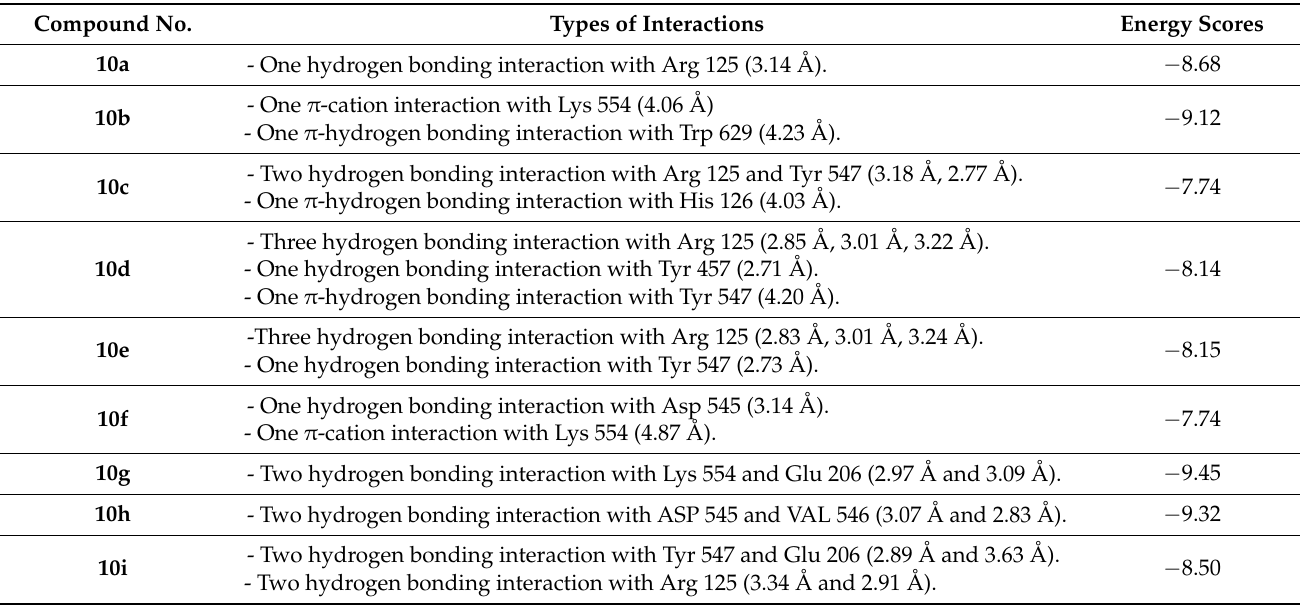
Table 3. Types of binding interactions and energy scores (kcal/mol) for hybrids 10a–j and alogliptin at the DPP-4 active site. Compound No. Types of Interactions Energy